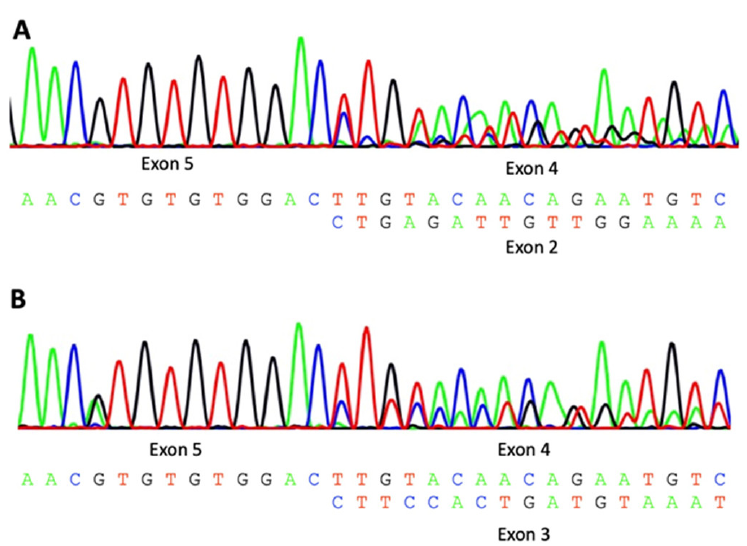
Figure 2. cDNA sequencing of P3 ( A ) and M3 (( B ); does not carry the c.349-1G>A variant) with skip- ping of exon 3 and 4 in P3 and skipping of exon 4 only in M3 (alternative transcript, NM_001378231.1). In P4, the novel second missense variant c.475A>C is classified as VUS, but with a CADD score of 24, is not listed in gnomAD and is predicted to be disease causing by